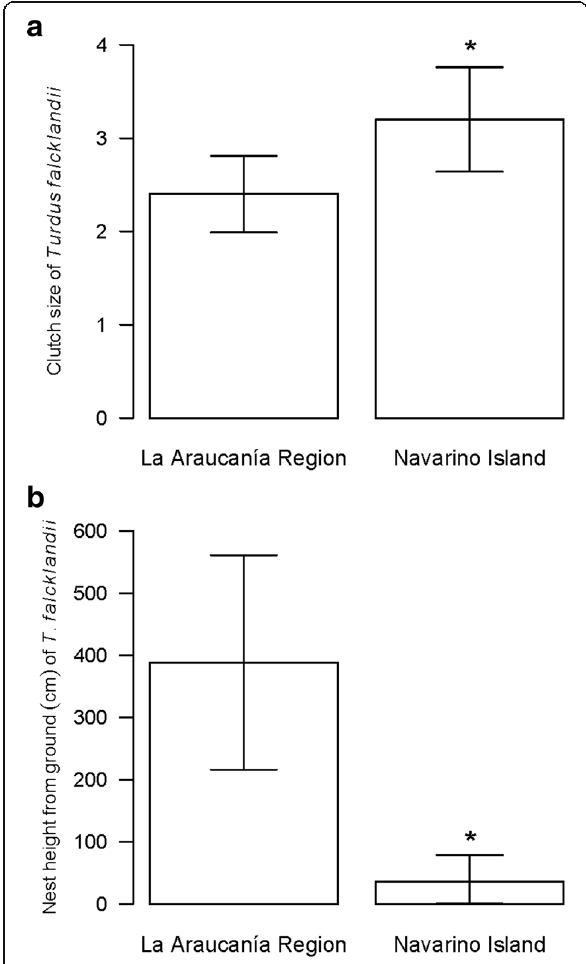
Fig. 4 Comparison of nesting strategies of Turdus falcklandii between different populations. a Nest height (cm from the ground) for La Araucanía Region ( n =12) and Navarino Island ( n =8) breeding populations. b Clutch size for La Araucanía Region ( n =9) and Navarino Island ( n =5). Bar heights represent mean value, and vertical bars represent 95% Confidence Intervals. * represents statistical difference compared to La Araucanía